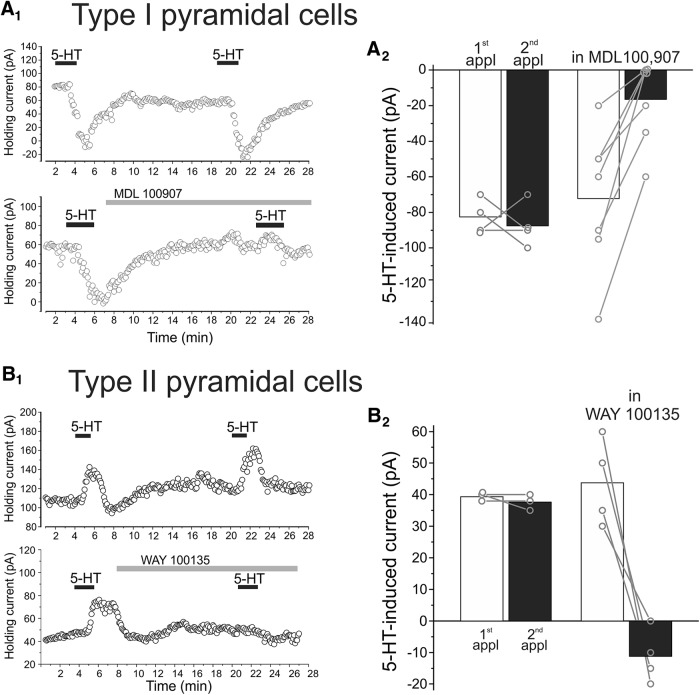
Pharmacology of serotonin responses in type I and type II L5 pyramidal cells of rat mPFC. A1, Top, two consecutive applications of serotonin (10 μm) to a type I pyramidal cell results in comparable inward currents indicating minimal desensitization of the response. Bottom, administration of the selective 5-HT2A receptor antagonist MDL100 907 (300 nm) between serotonin application inhibits the effect of a second serotonin application. A2, Summary plot illustrating the effect of MDL100907 on the inward current elicit by serotonin on type I pyramidal cells. B1, Top, two consecutive applications of serotonin (10 μm) to a type II pyramidal cell elicit comparable outward currents. Bottom, administration of the selective 5-HT1A antagonist WAY100135 (3 μm) between serotonin application blocks the effect of a second application of serotonin. B2, Summary plot illustrating the effect of WAY100135 on the outward current elicited by serotonin in type II pyramidal cells.